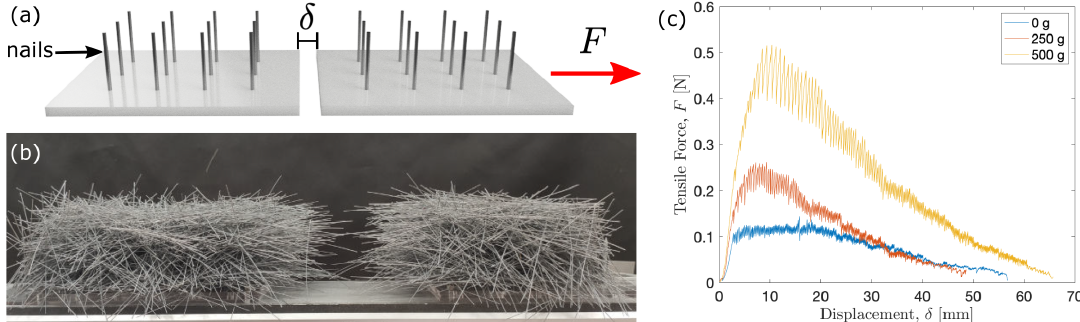
Figure 4. (a) Scheme with the double bed of nails setup used for the traction test. (b) Snapshot of a traction test after fracture. (c) Force-displacement curves of axial traction for 3 pre-compression